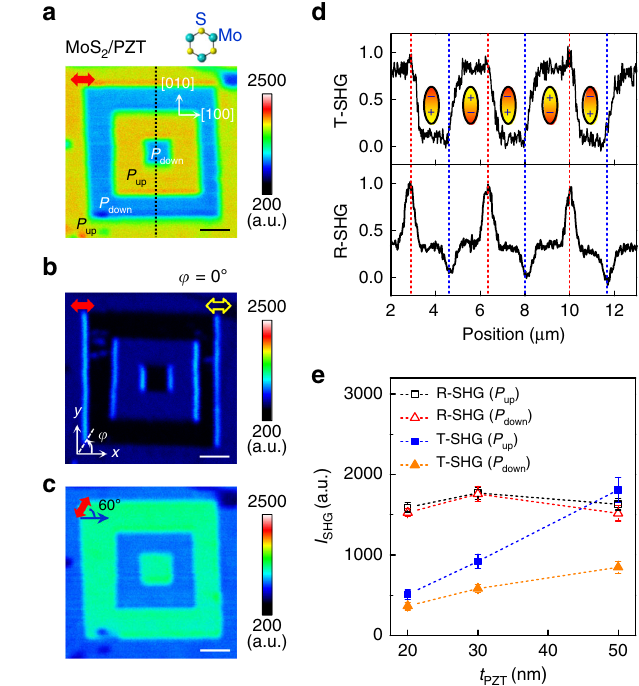
Fig. 4 Transmitted SHG response of 1L MoS 2 /PZT interface. a – c SHG mapping in transmission mode of the same MoS 2 /PZT sample shown in Fig. 2 taken with no analyzer applied ( a , c ) and with a horizontal analyzer applied ( b ). The red solid (yellow open) arrows mark the incident light (analyzer) polarization. The crystalline orientations of PZT and MoS 2 are shown as insets in a . The scale bars are 2 μ m. All images were taken at the excitation laser power of 20 mW. d Normalized SHG intensity pro fi les obtained in the transmission (T-SHG) and re fl ection (R-SHG) modes along the black dotted line in a . The dashed lines serve as the guide to the eye. e Averaged SHG intensity as a function of PZT thickness taken on the P P fl ection (open up (squares) and down (triangles) domains in both re symbols) and transmission (solid symbols) modes at excitation laser power of 20